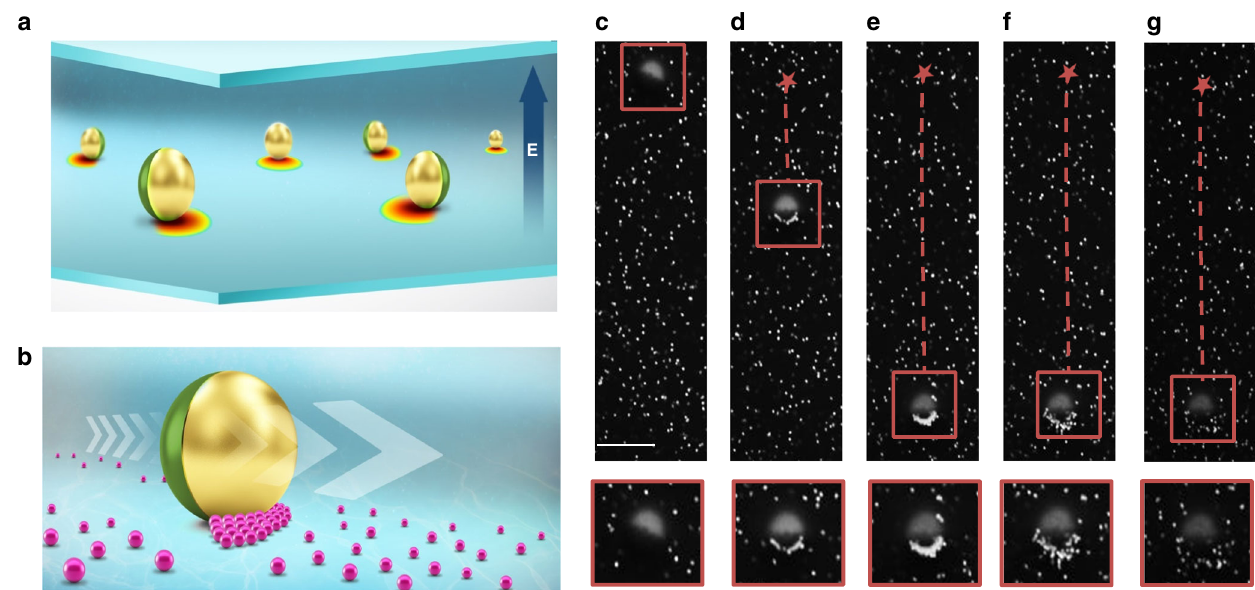
Fig. 1 Mobile microelectrode applied to cargo transport. a Schematic of the general concept of mobile microelectrode; localized gradients are induced around polarizable surface such that the spatial distribution of the fi eld gradient in the system may be varied by manipulating the position of the Janus sphere; b Schematic illustrating concept of cargo transport; Janus particle picks up cargo, as it translates and transports it to a secondary location. c – g Microscope images showing accumulation, transport and release of 300 nm target by a 15 µ m Janus particle carrier controlled by the frequency of the applied electric fi eld.Video available in real time as Supplementary Video 1. c – e At 100 kHz, the 300 nm target accumulates at the metallic hemisphere under attractive pDEP. f , g At 2 MHz the target experiences a negative nDEP force and is ejected from the carrier surface. Scale bar illustrated in c is 10 µ